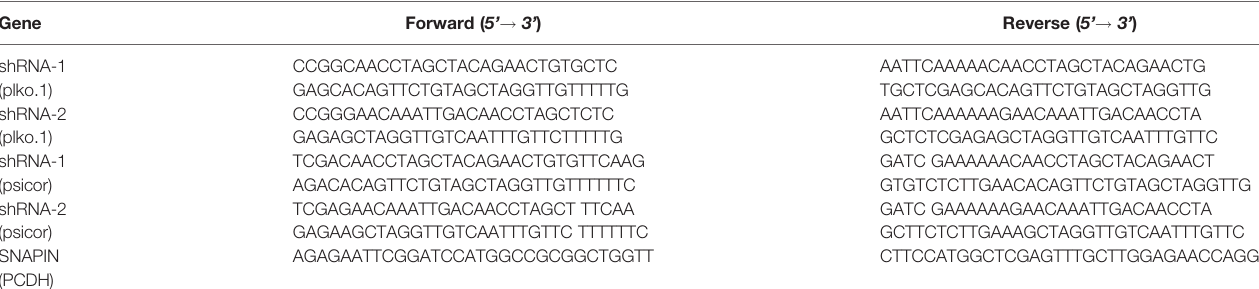
TABLE 1 | shRNA targeting sequencing and primers for SNAPIN